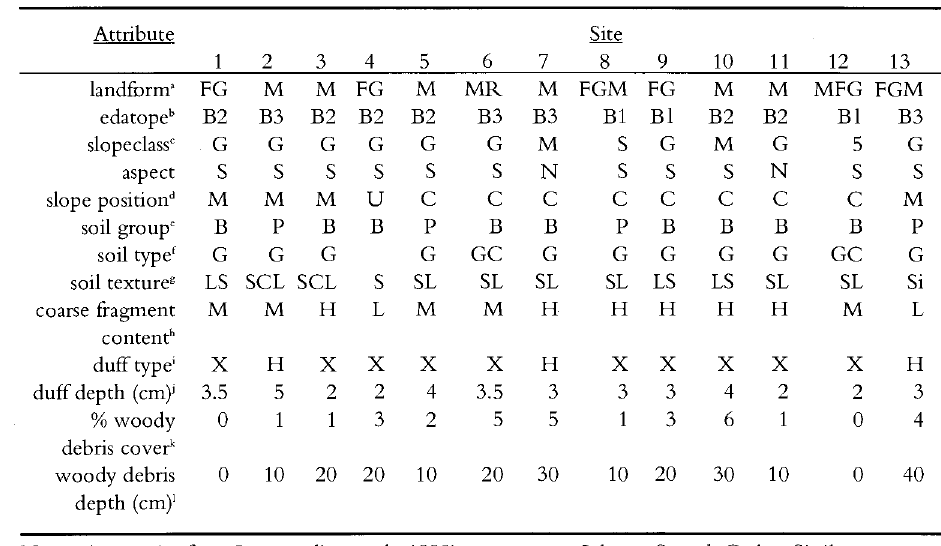
B L loam; S sand; C clay; Si silt. h H high; M moderate; L low. ' X xeromor; H hemimor. J Depth to first mineralized horizon. k Logs, dead branches etc. 1 Size (diameter) of debris, or height elevated above ground surface (whichever was